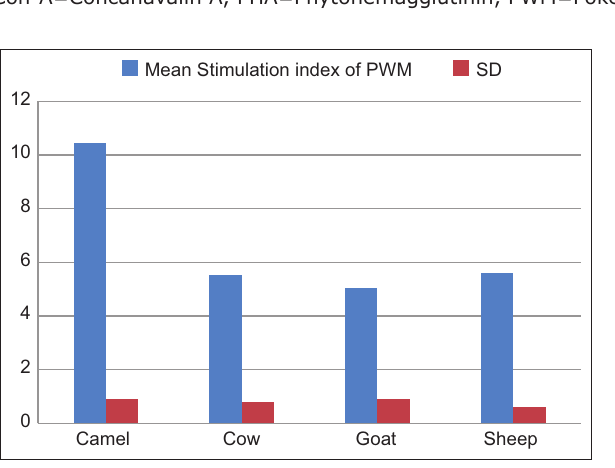
Figure-5: Comparison of stimulation indices of peripheral blood mononuclear leukocytes from camels, goats, sheep, and cows with phytohemagglutinin.